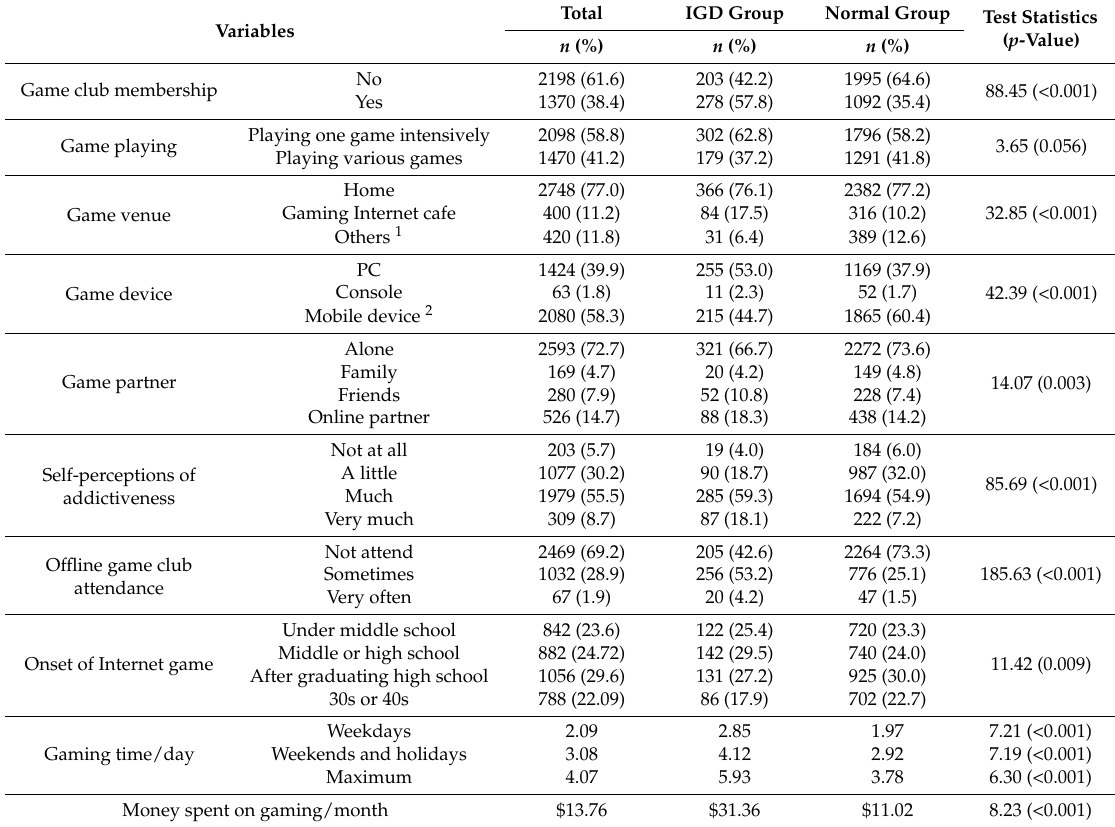
Table 3. Internet gaming